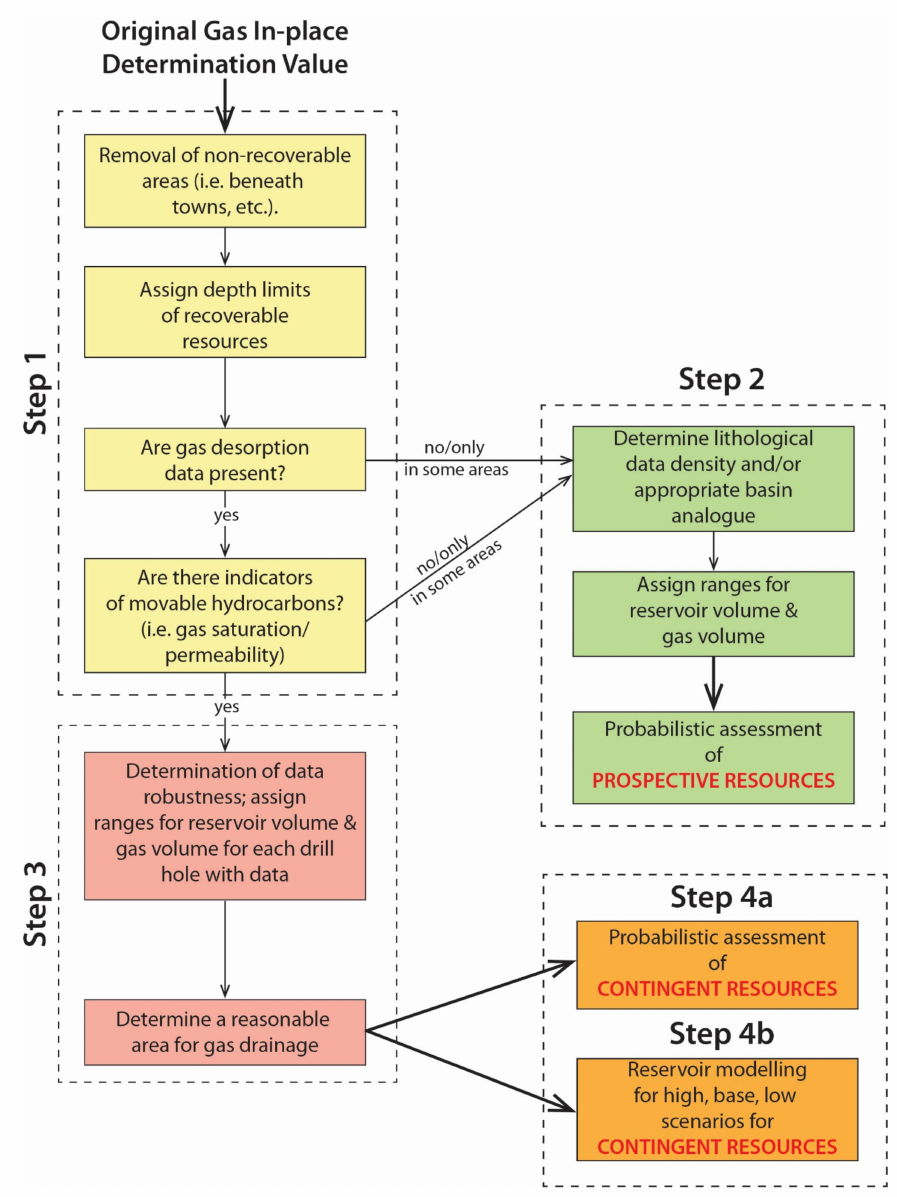
Figure 13. One possible workflow scenario for determination of Prospective and Contingent